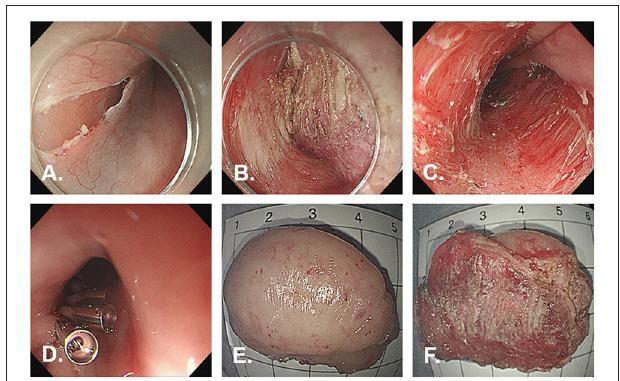
FIGURE 3 | Images during endoscopic submucosal dissection. Endoscopic submucosal tunnel dissection is performed without any complication. (A) Initial incision of the mucosa after injection. (B) Exposure of the tumor. (C) The wound after ESD. (D) Complete closure of the mucosal incision site with endoclips. (E) On the external surface of the resected specimen. (F) On the cut surface of the resected